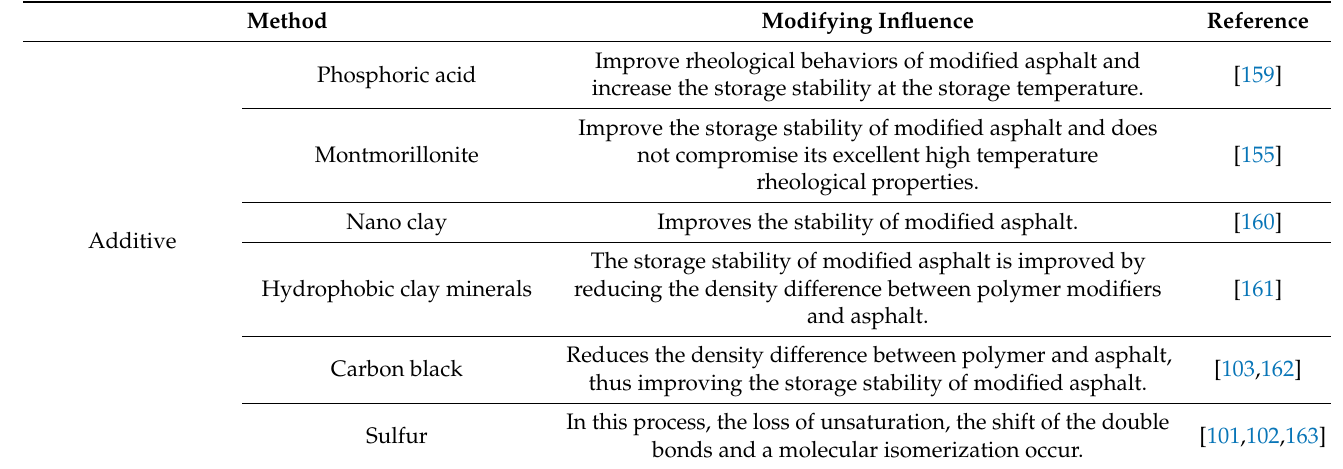
Table 7. The influences of additives and functionalization on the improvement of